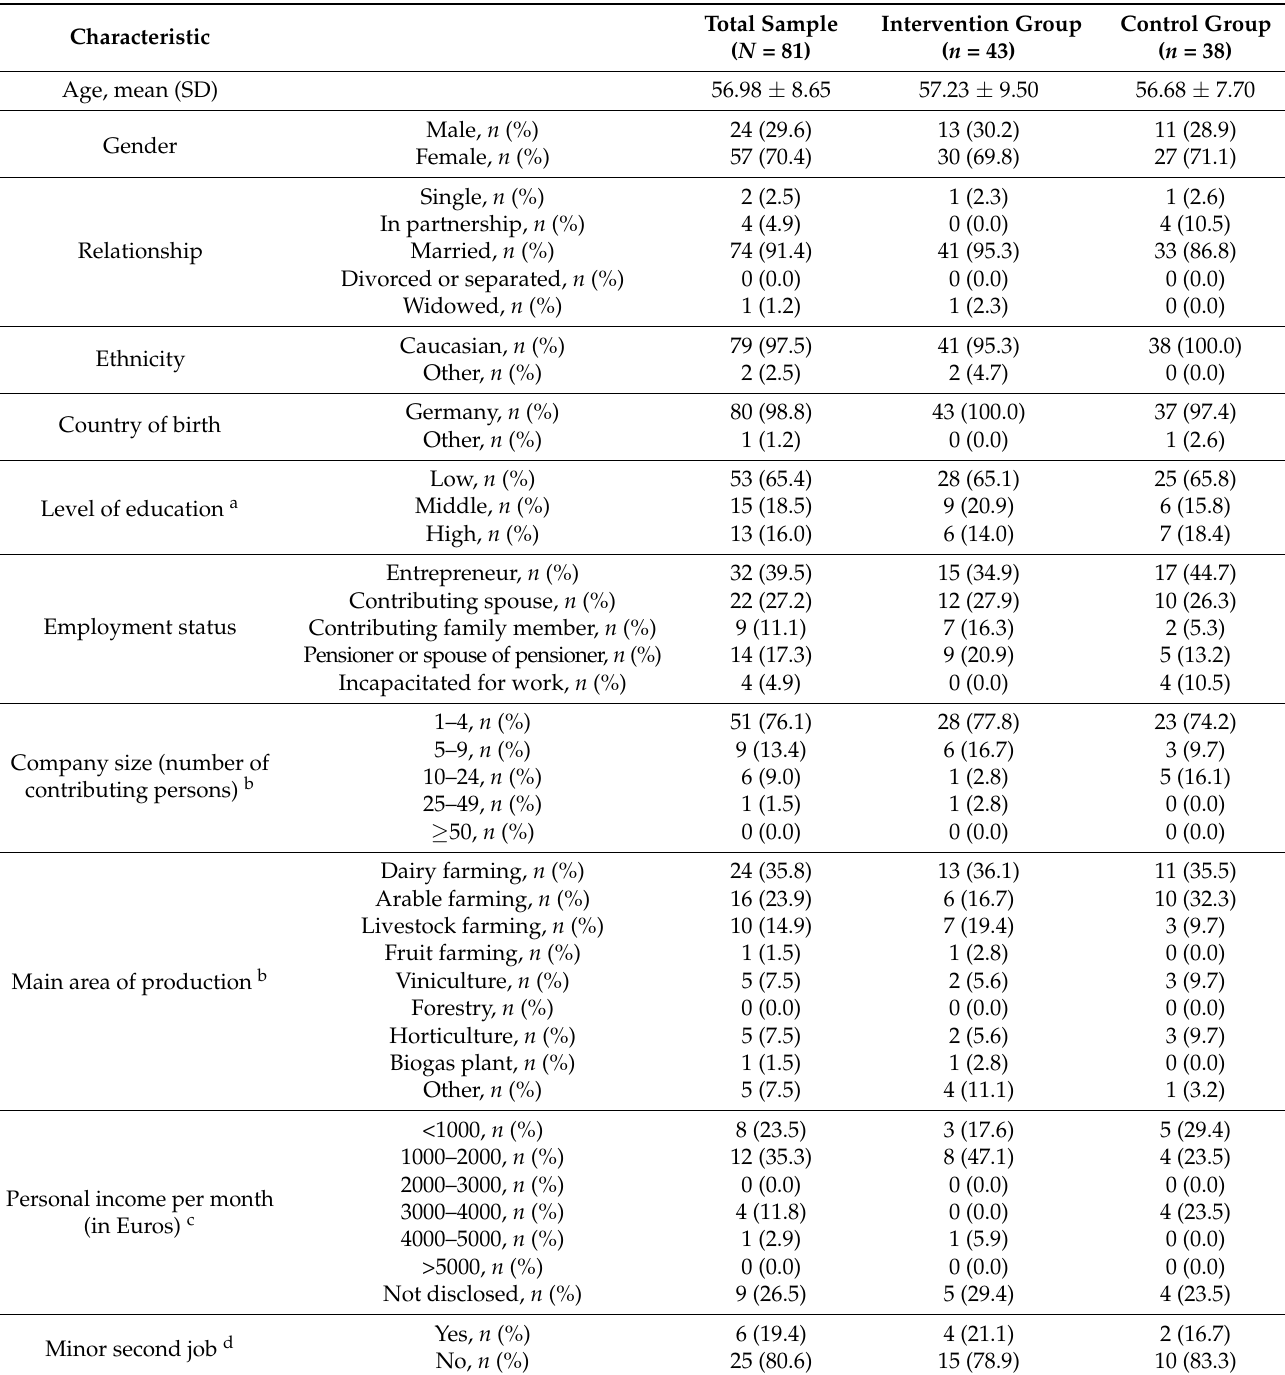
Table 1. Baseline characteristics per study